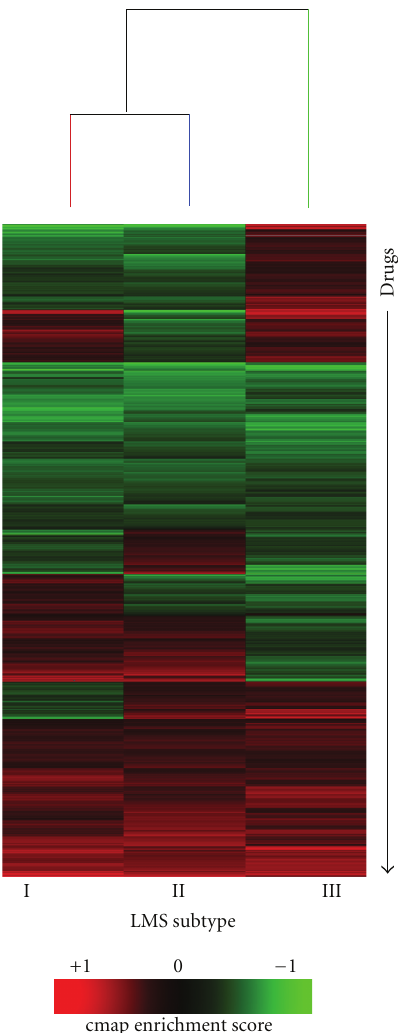
Figure 2: Connectivity Map to identify drugs to target leiomyosar- coma subtypes. Unsupervised hierarchical clustering of the drugs (along the y -axis) and three LMS subtypes (along the x -axis). The heatmap displays the enrichment score of each drug with each LMS subtype. Green indicates negative enrichment and red indicates positive enrichment. We used these data to test whether the direction and/or magnitude of cmap enrichment scores could predict drug response in LMS cell lines. Full results from the Connectivity Map analysis are provided in Supplemental Table